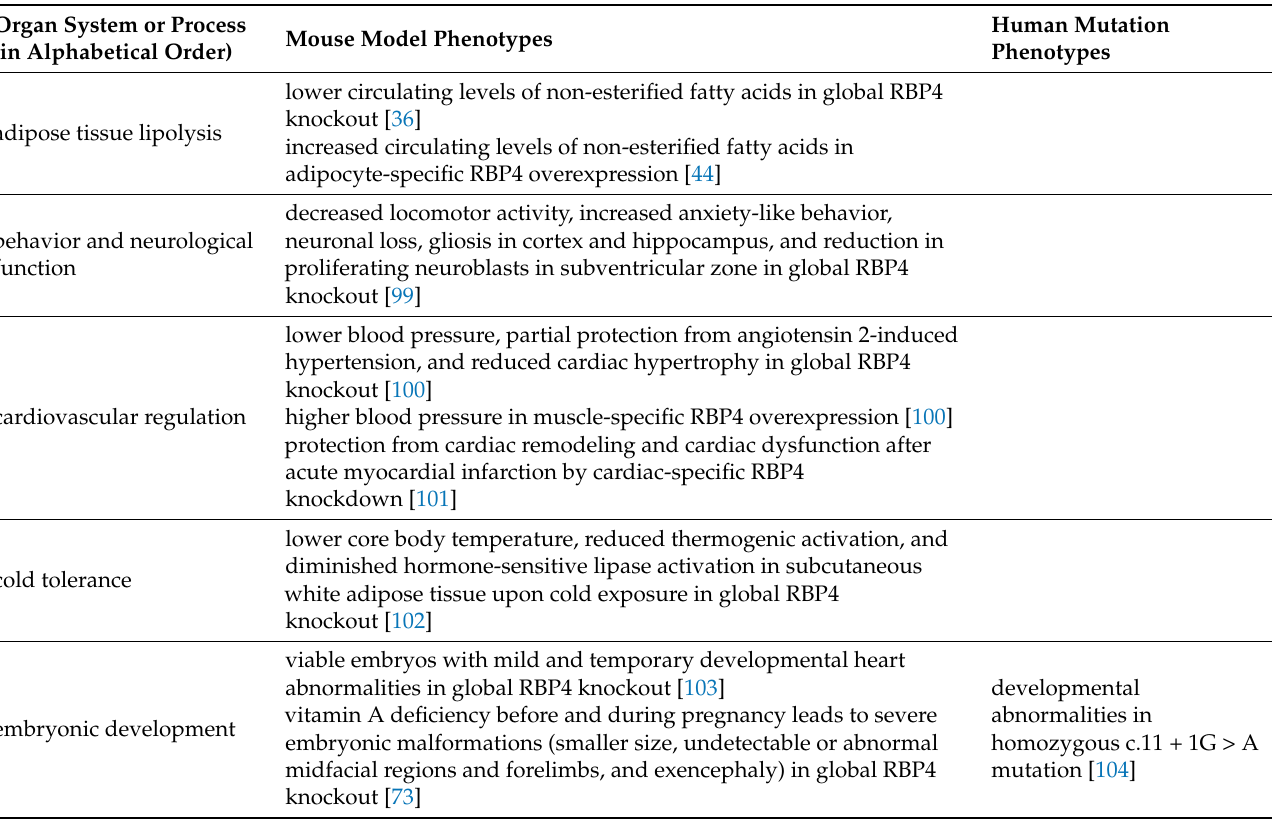
Table 1. RBP4 mouse models and human mutations and their phenotypes in different organs systems and